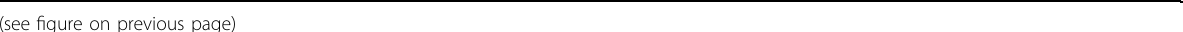
Fig. 5 MDM4 expression affects mTOR activation. a Pathway analysis of mTOR signaling in SK-OV-3 cells. Red and green colors underlie proteins differently expressed in MDM4- compared with Empty vector-SK-OV-3 cells (red = upregulated, green = downregulated proteins). b WB of Empty Vector or MDM4-SK-OV-3 cells showing S6K1 and p70S6K1 T389 expression (left panel) and quanti fi cation (right panel) ( n = 3, one-sample t test p < 0.001). c WB of indicated proteins in tumor nodules (one per mouse) generated by IP injection of Empty Vector or MDM4-SK-OV-3 cells in mice; lower panels show quanti fi cation ( n = 7 mice, two-sided Student ’ s t test, *** p < 0.001, * p = 0.048). d SunSet assay of Empty Vector- and MDM4-SK-OV-3 cells treated with rapamycin for 6 hours; quanti fi cation of two independent assays (right panel). e WB of indicated prot e ins in whole-cell extract (WCE) and co-immunocomplex from SK-OV-3 cells grown in EBSS for 1 hour and then in absence or presence of complete medium for additional 1 hour (CM). 1 mg of WCE was immunoprecipitated with anti-MDM4 antibody (IP α MDM4) or control Ig (IPCTL). Right panel shows the analysis of 1/100 of